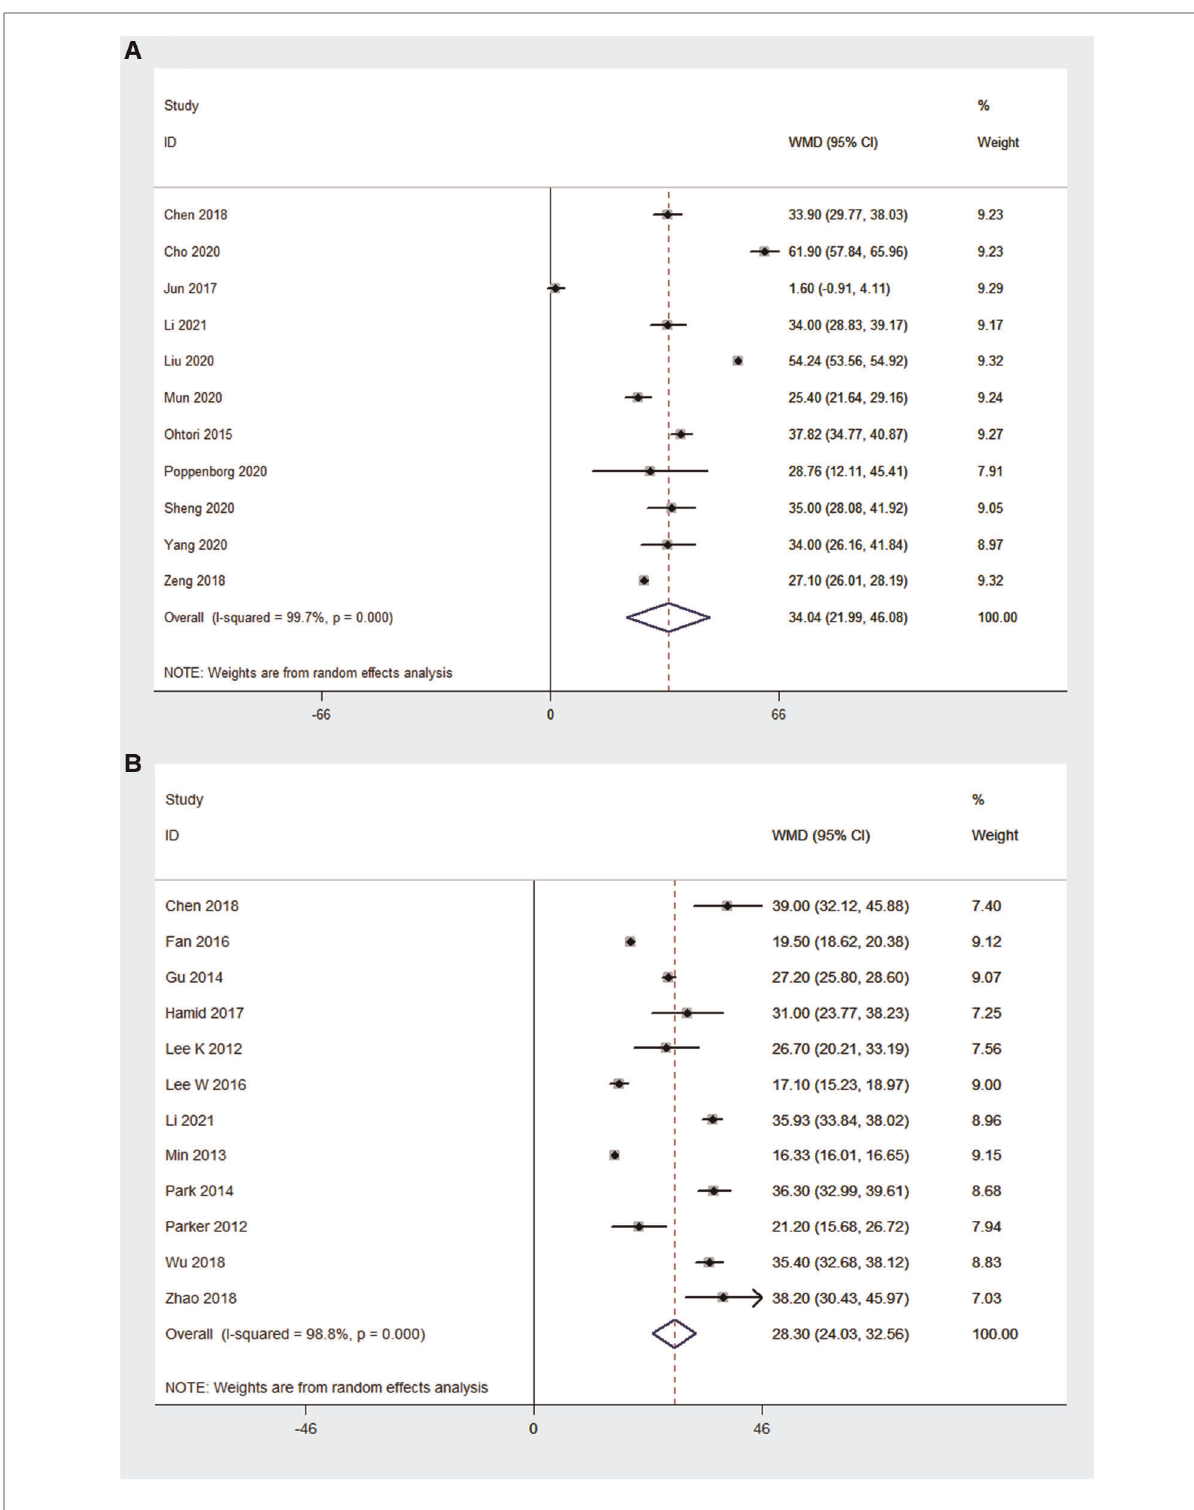
FIGURE 8 Forest plot and pooled estimates of Oswestry disability index. Outcomes assessed are ( A ) OLIF group; ( B ) MI-TLIF